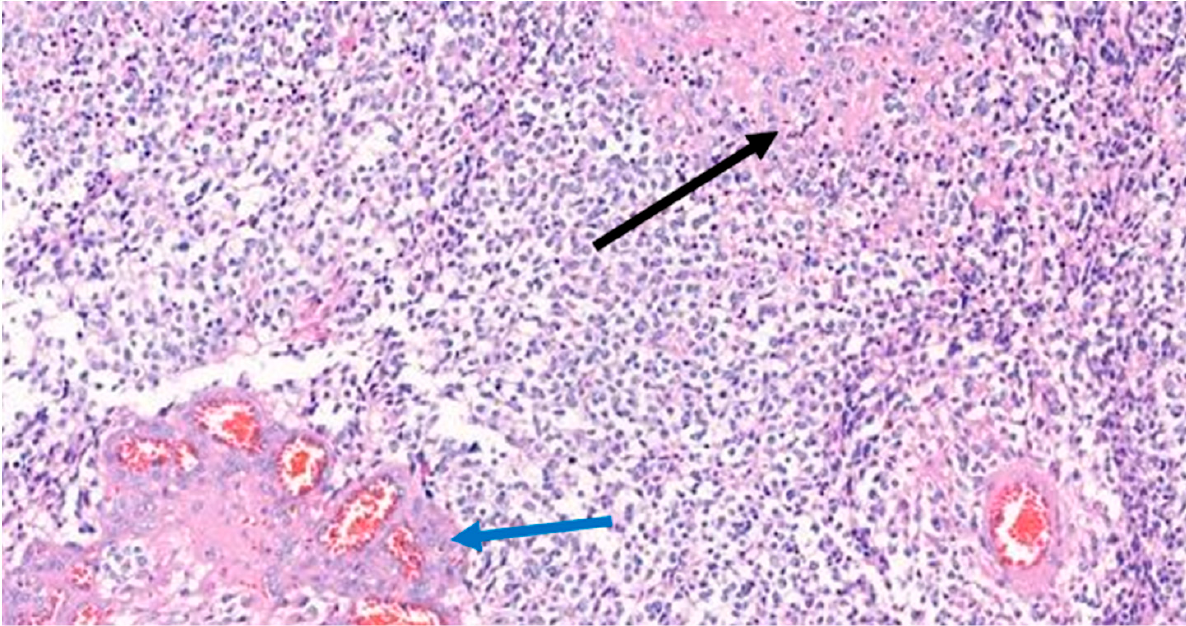
Figure 4. Histological examination of the tumor. Necrosis and high cellularity were noted. Numerous blood vessels of varying sizes were also noted within the tumor. Hematoxylin and eosin stain, magnification 50×.